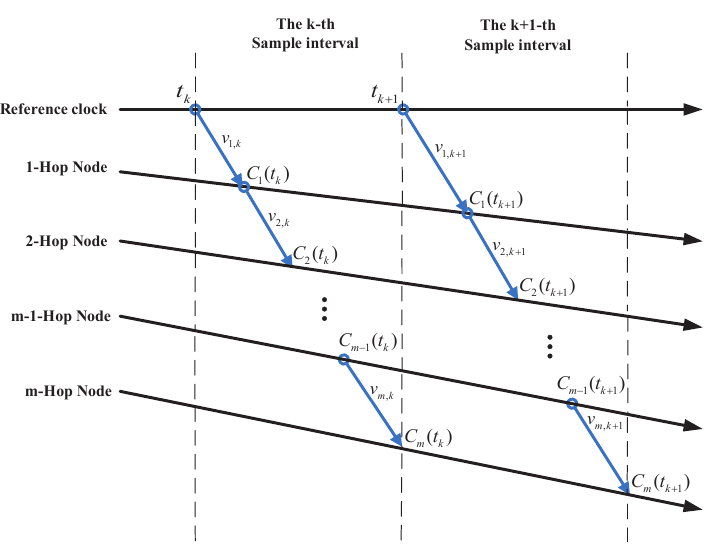
Figure 3. Multi-hop Clock Synchronization